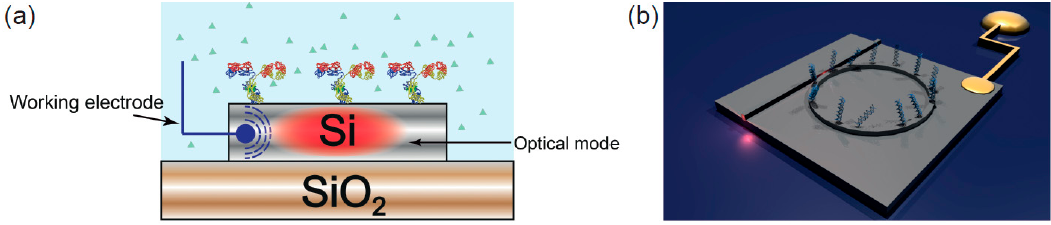
Figure 6. Electrophotonic silicon biosensing. ( a ) Cross section of an electrophotonic silicon biosensor. The electrochemical functionality is provided by doping the surface of the silicon waveguide layer; ( b ) Sketch of an electrophotonic silicon sensor based on a ring resonator structure.